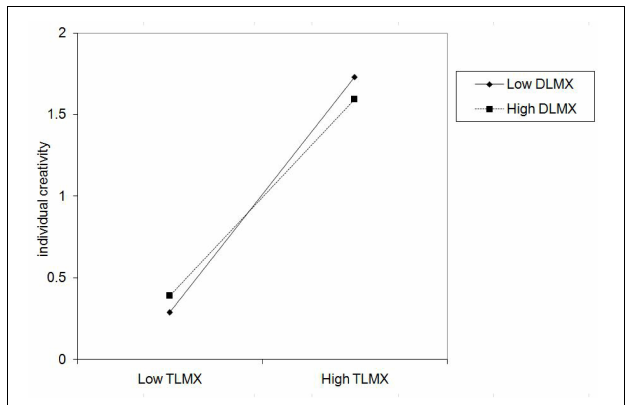
FIGURE 5 | Interaction of TLMX and DLMX on individual